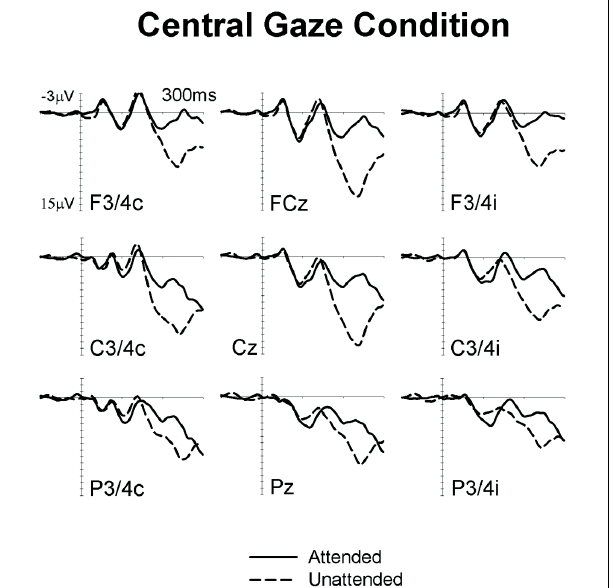
FIGURE 2 | Grand-averaged somatosensory ERPs elicited in the Central gaze condition at midline electrodes, and at sites contralateral (C) and ipsilateral (I) to the stimulated hand, by tactile non-target stimuli presented to the attended hand (solid lines) and to the unattended hand (dashed lines) in the 300 ms following stimulus onset (relative to a 100 ms pre-stimulus